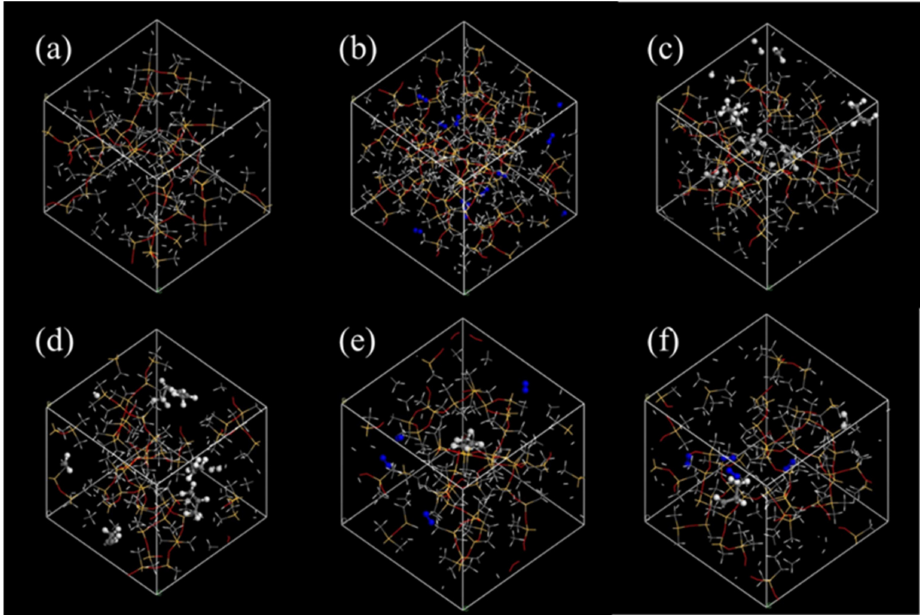
Figure 1. Structures of the membrane cells of ( a ) PDMS, ( b ) PDMS + N 2, ( c ) PDMS + C 3 H 8 , ( d ) PDMS + C 3 H 6 , ( e ) PDMS + C 3 H 8 /N 2 and ( f ) PDMS + C 3 H 6 /N 2